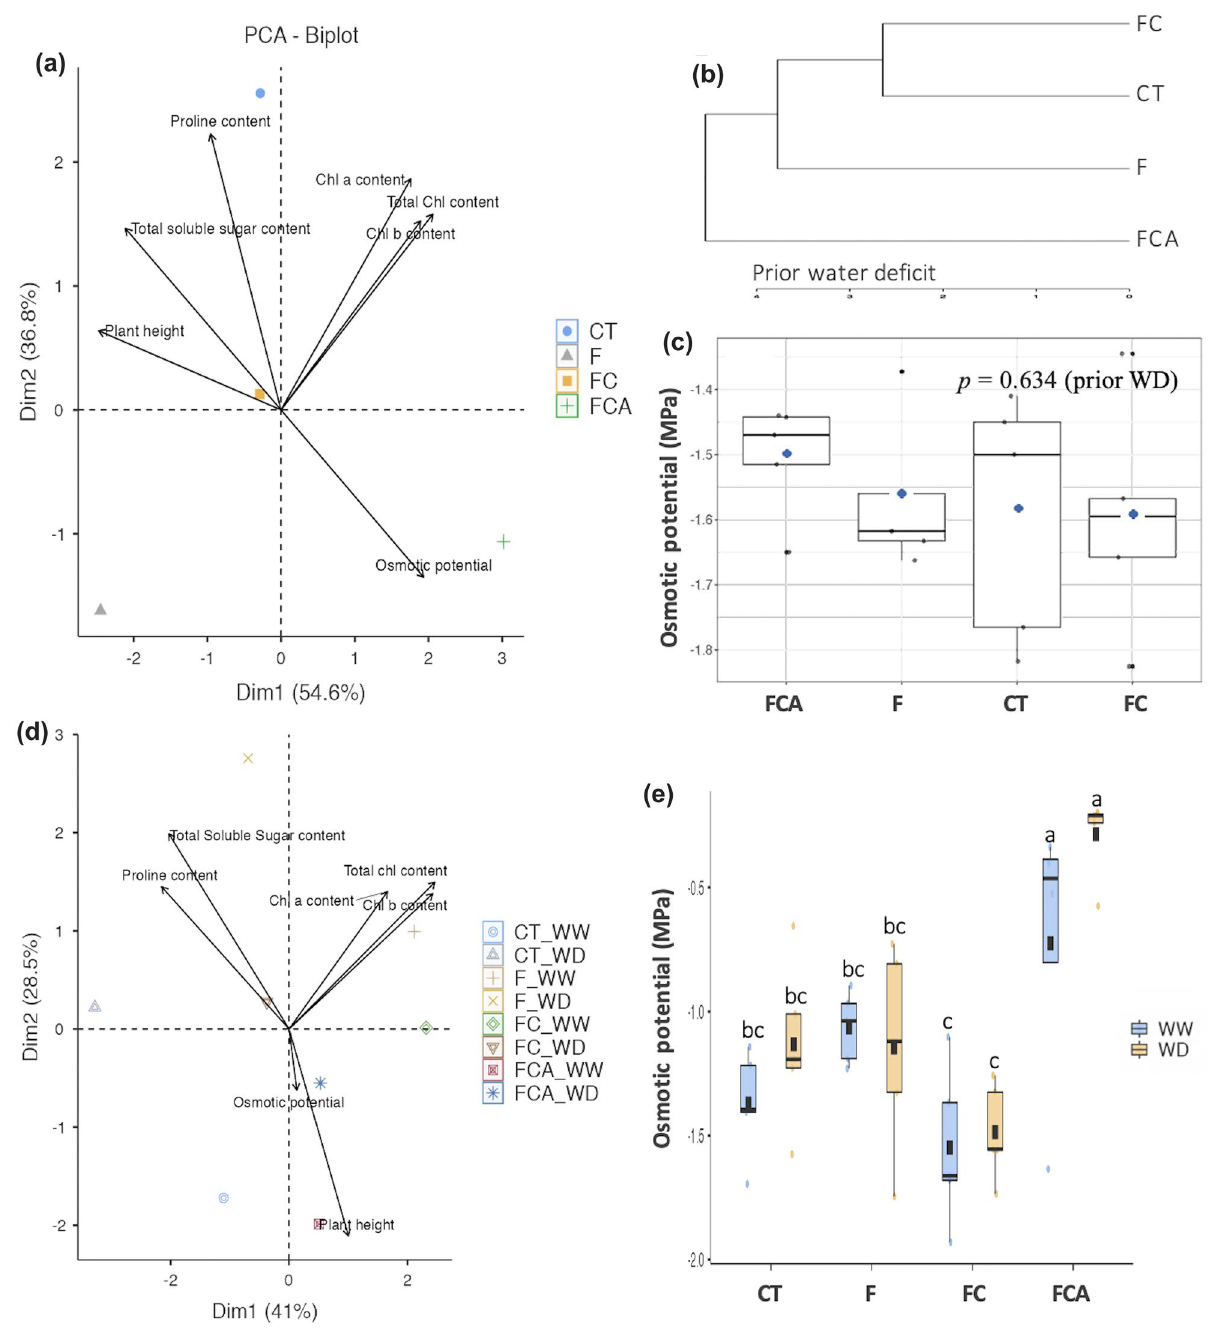
Figure 4. Principle component analysis, PCA, and group clustering ( a and b ) in rice cv. Leum Pua inoculated with or without AMFs (F, FC, FCA, and CT; the codes are included in Fig. 1) indicated by physiological, biochemical, and growth parameters, including plot of osmotic potential, data sorted by means, ( c ) under prior water limitation (0 day). The PCA ( d ) and the osmotic potential ( e ) represents on the 21st day of well-watered and water deficit conditions. Statistical data access with a minimum of n = 4 and mean ± standard deviation. Different letters along plots represent significant difference at p =